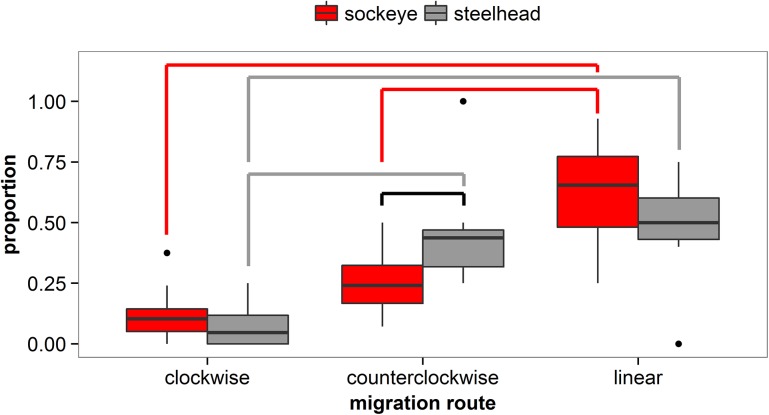
Boxplots of the proportion of sockeye salmon and steelhead smolts exhibiting linear, counterclockwise, and clockwise migration behaviors.Box limits represent the 25th and 75th percentile values. Lines indicate significant differences in proportions between migration routes for sockeye (red; Tukey HSD), and steelhead (grey; Tukey HSD), or between species within a migration route (black; t-test).